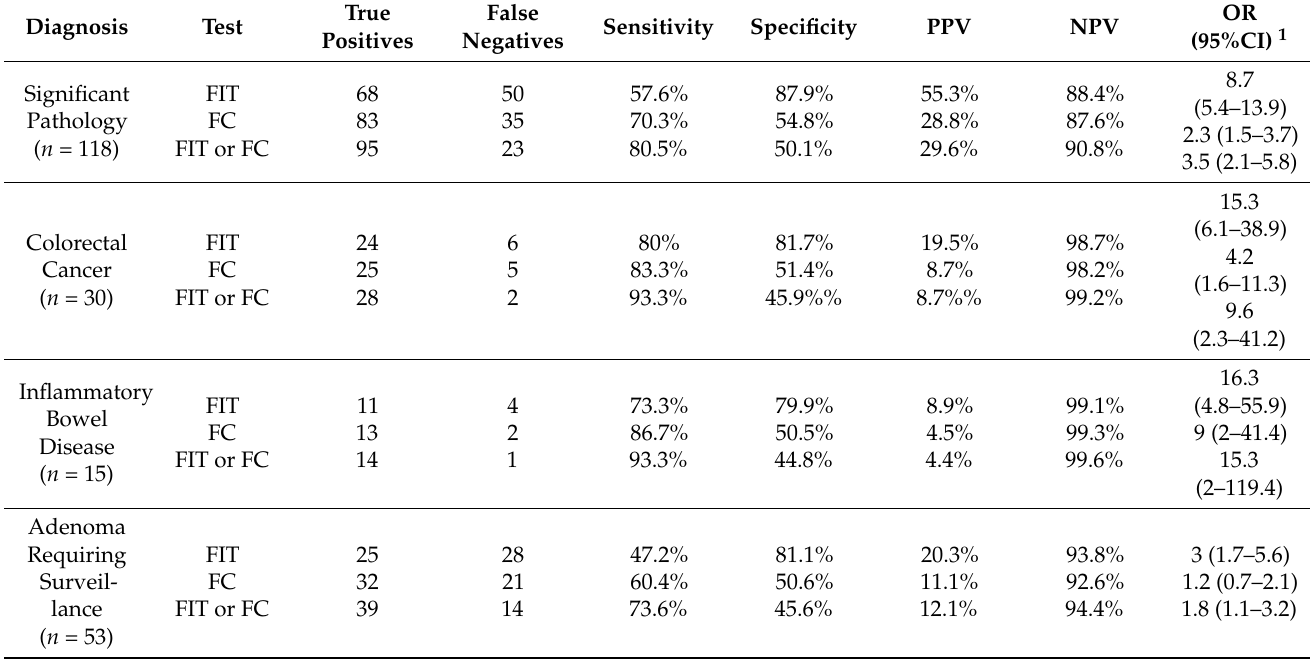
Table 2. Diagnostic accuracy of FIT, FC, and the combination.